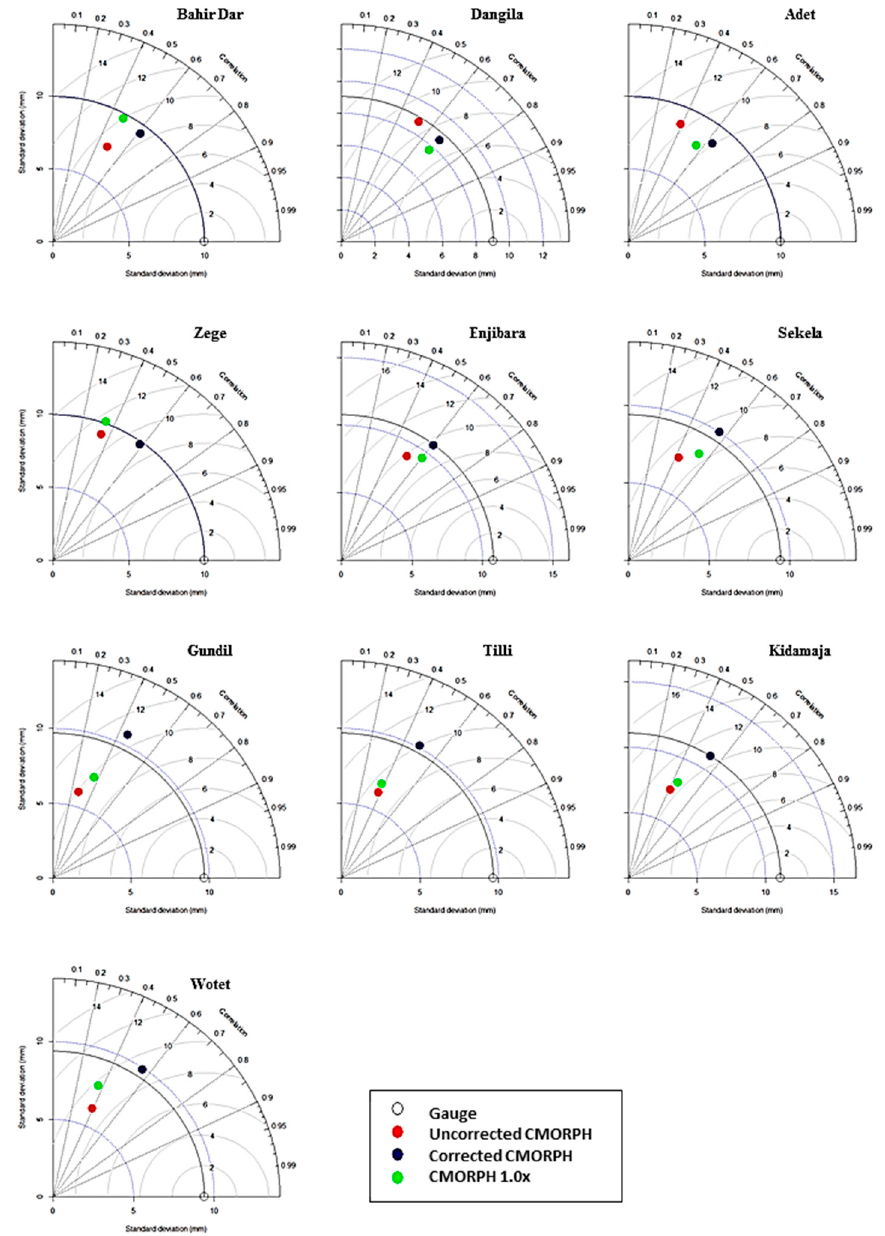
Figure 7. Taylors Diagram illustrating statistical comparison between uncorrected CMORPH, corrected CMORPH, CMORPH version 1.0 and the gauge rainfall (the bench mark). The azimuthal angle represents correlation coefficient; radial distance represents standard deviation (mm/day) of the rainfall time series and green contours represent RMSE (mm/day).